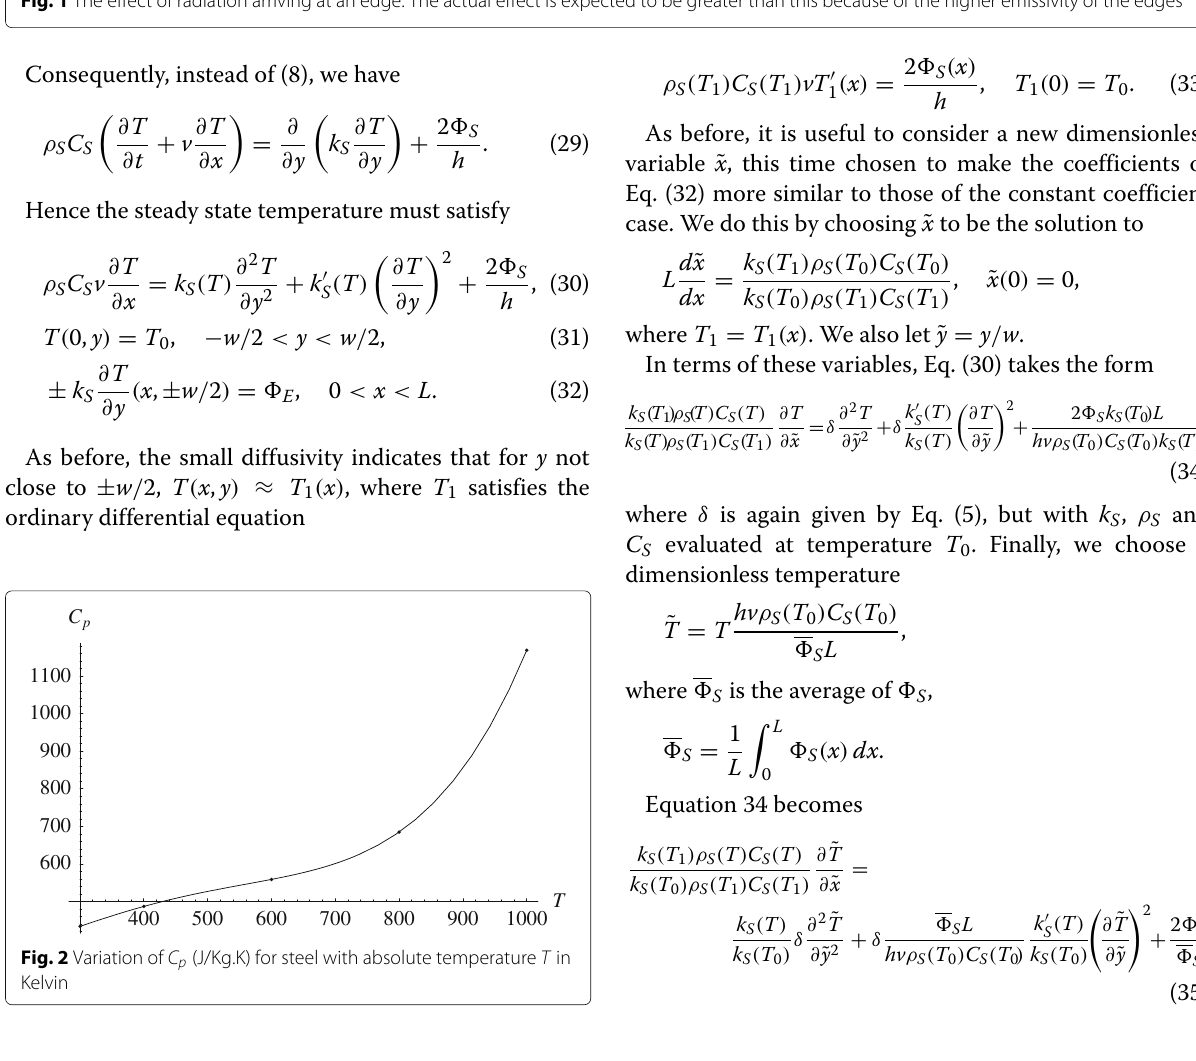
Fig. 1 The effect of radiation arriving at an edge. The actual effect is expected to be greater than this because of the higher emissivity of the edges